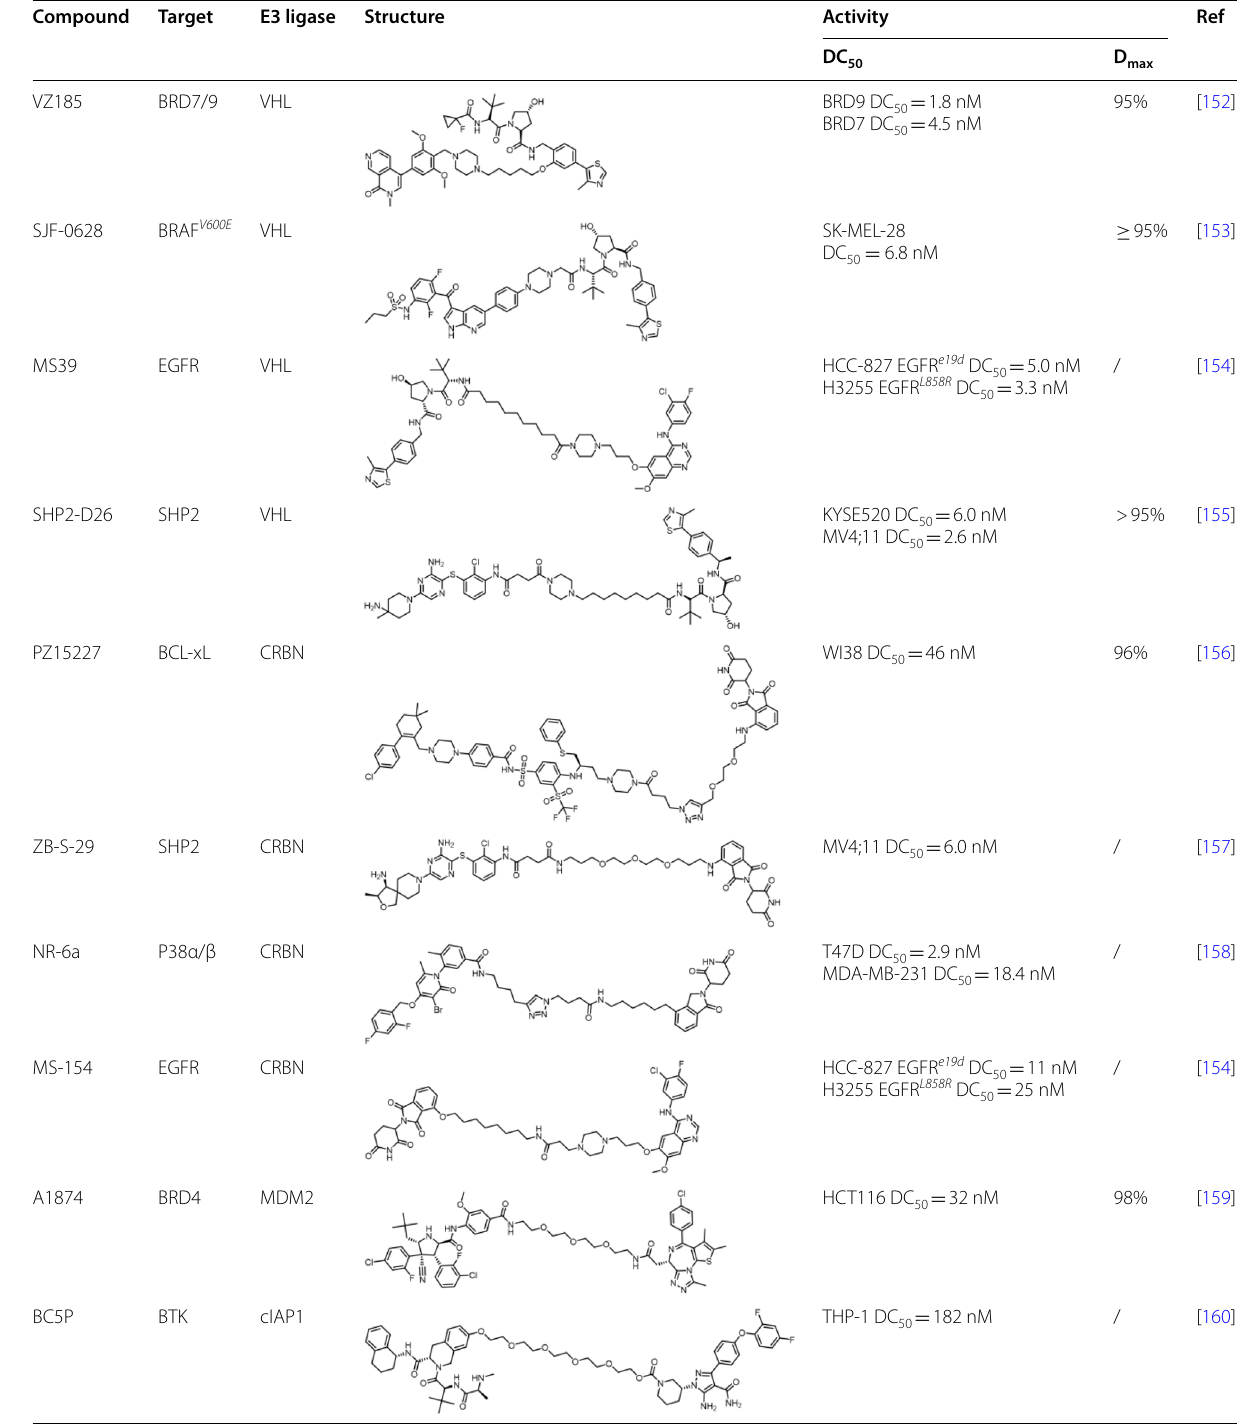
Table 4 Representative compounds of PROTACs reported since 2019